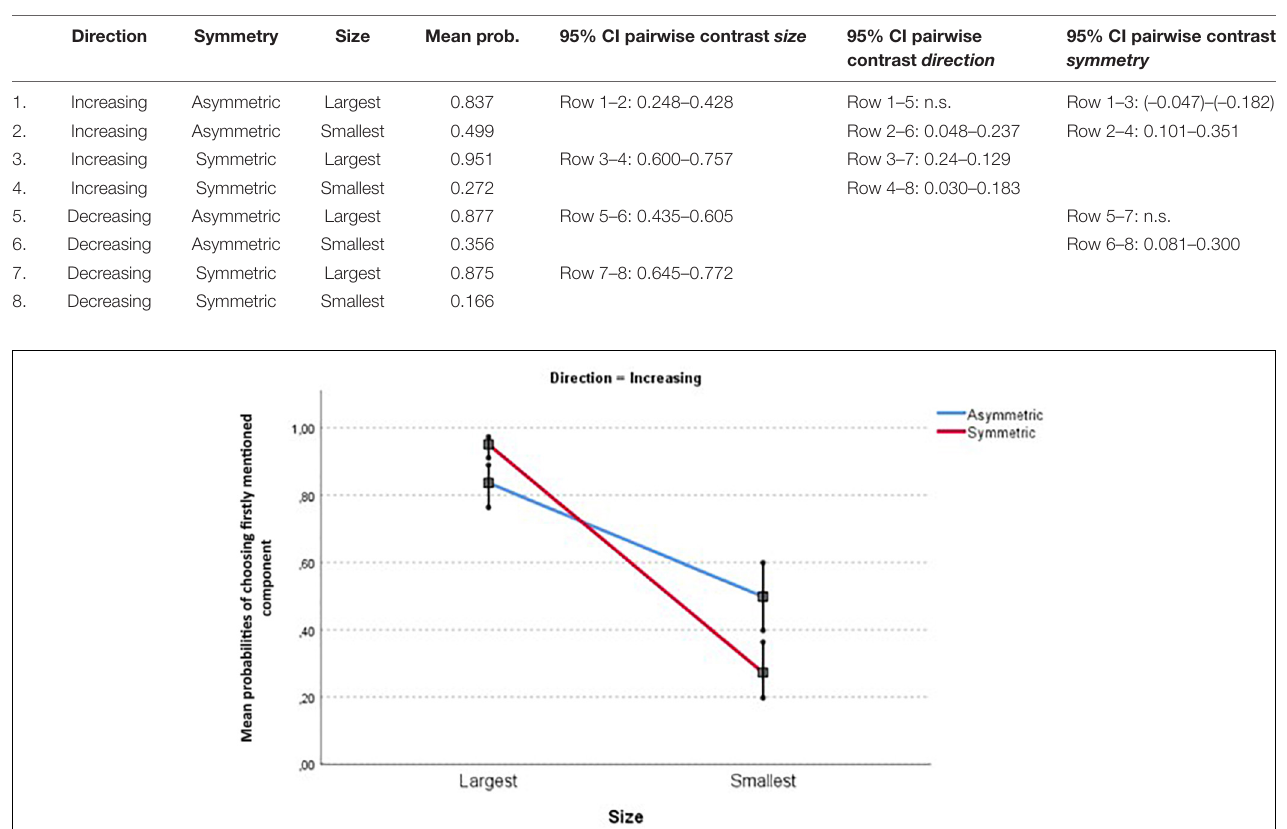
TABLE 3 | Probabilities involved in the three-way interaction in experiment 1.